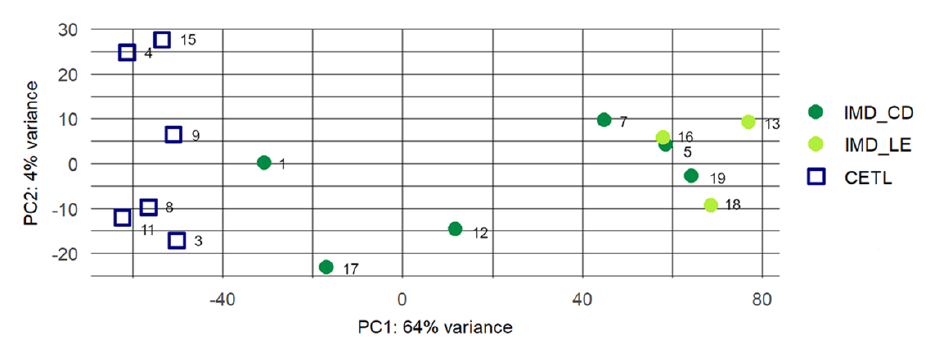
Figure 1. Principal component analysis of the RNA sequencing output. The PCA plot is calculated on the basis of 5000 genes most differentially expressed between canine CETL and IMD skin samples. Distances between samples reflect differences in the transcriptome profile of the samples.